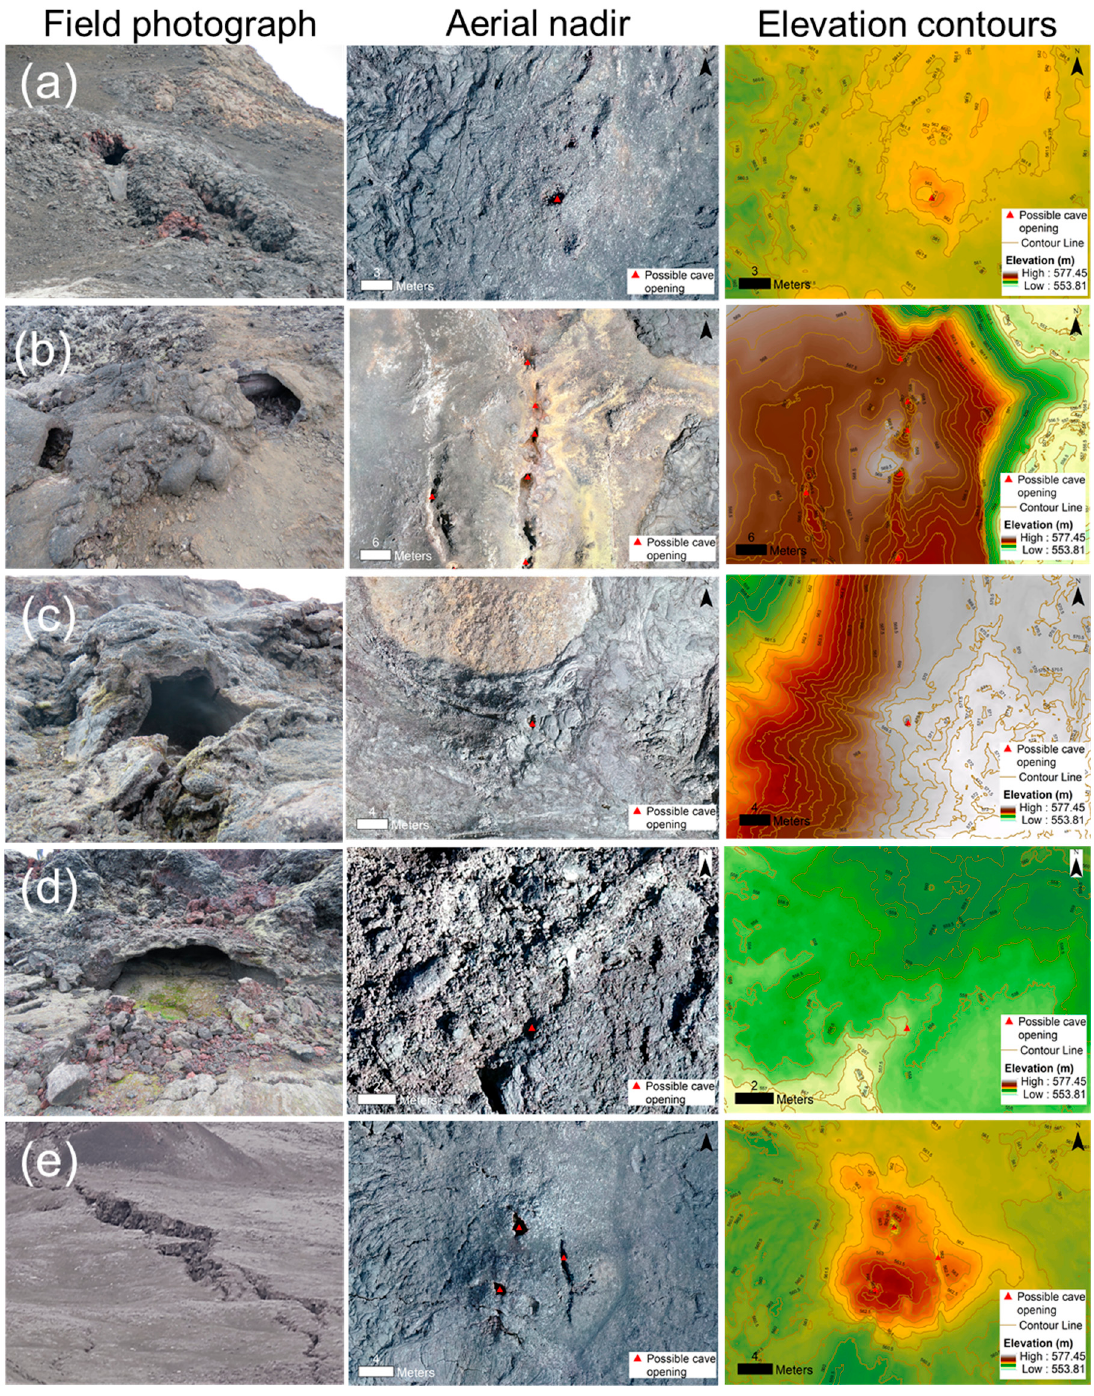
Figure 8. Types of possible small cave openings observed in the study area: ( a ) open vertical conduit; ( b ) collapsed small lava tunnel; ( c ) tumulus cave; ( d ) lava rise cave; ( e ) surface fractures. All the zoomed-in elevation maps are presented with respect to a common elevation scale to enables observing relative elevations and topography possible for each cave type.